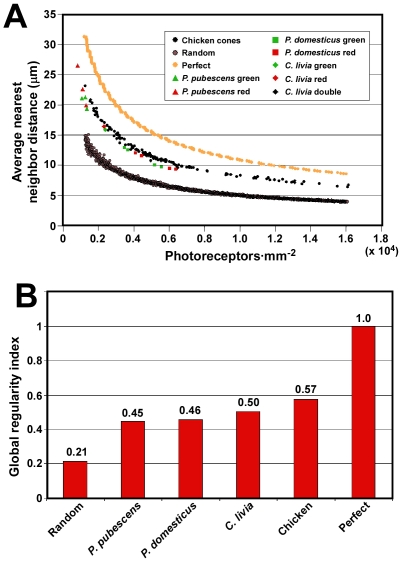
A range of bird species show similar cone patterning.(A) Graph of photoreceptor density vs. average nearest neighbor distance for three additional species of bird representing three different orders. All P15 chicken datapoints are shown in black for clarity. P. pubescens, Picoides pubescens; P. domesticus, Passer domesticus; C. livia, Columba livia. (B) Graph of the global regularity indices for all four bird species examined as well as for computer-generated random and perfect distributions. The global regularity index is the inverse of the slope of the best fit linear curves of the form, y  =  mx, for each of the datasets as shown in Figure S3. All values are normalized to that for perfect which is set equal to one.